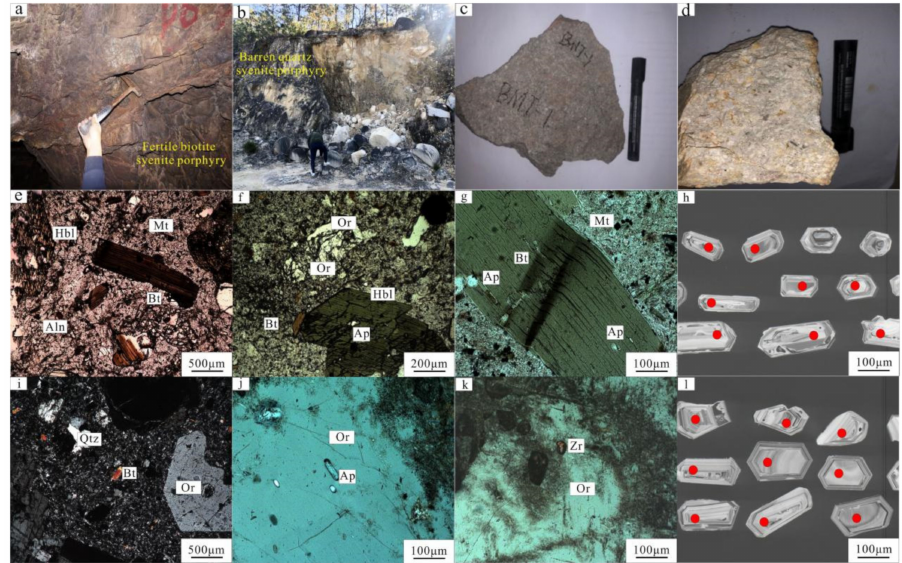
Figure 3. Field photographs, micrographs and CL images illustrating the petrographic, characteristics of rock samples, and the occurrence features of apatite grans. ( a , b ) Field photographs of fertile biotite syenite porphyry and barren quartz syenite poyphyry; ( c , d ) Hand specimen of biotite syenite porphyry and quartz syenite porphyry; ( e – g ) Microscopic characteristic of biotite syenite porphyry, show apatite grains are enclosed in hornblende and biotite; cross-polarized light; ( h , l ) CL images of apatites from biotite syenite porphyry and quartz syenite porphyry, show clearly oscillatory zone; ( i – k ) Microscopic characteristic of quartz syenite porphyry, show apatite and zircon grains are enclosed inorthoclase; cross-polarized light; ( k , l ) CL image of zircon and apatite from quartz syenite porphyry, show clearly oscillatory zone. Red circle are analysis points of EMPA and LA-ICP-MS respectively. Abbreviations: Or = orthoclase, Bt = biotite, Hbl = hornblende, Ap = apatite, Qtz = quartz, Mt = magnetite, Aln =